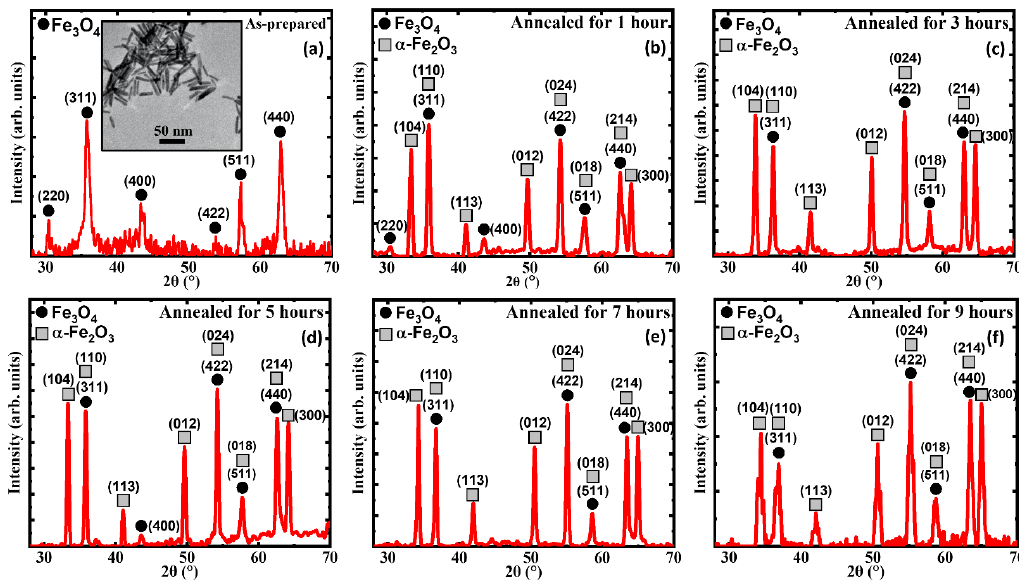
Figure 1. XRD patterns of the ( a ) as-prepared iron oxide nanorods (inset shows a TEM image of the as-prepared iron oxide nanorods), ( b ) 1 h annealed, ( c ) 3 h annealed, ( d ) 5 h annealed, ( e ) 7 h